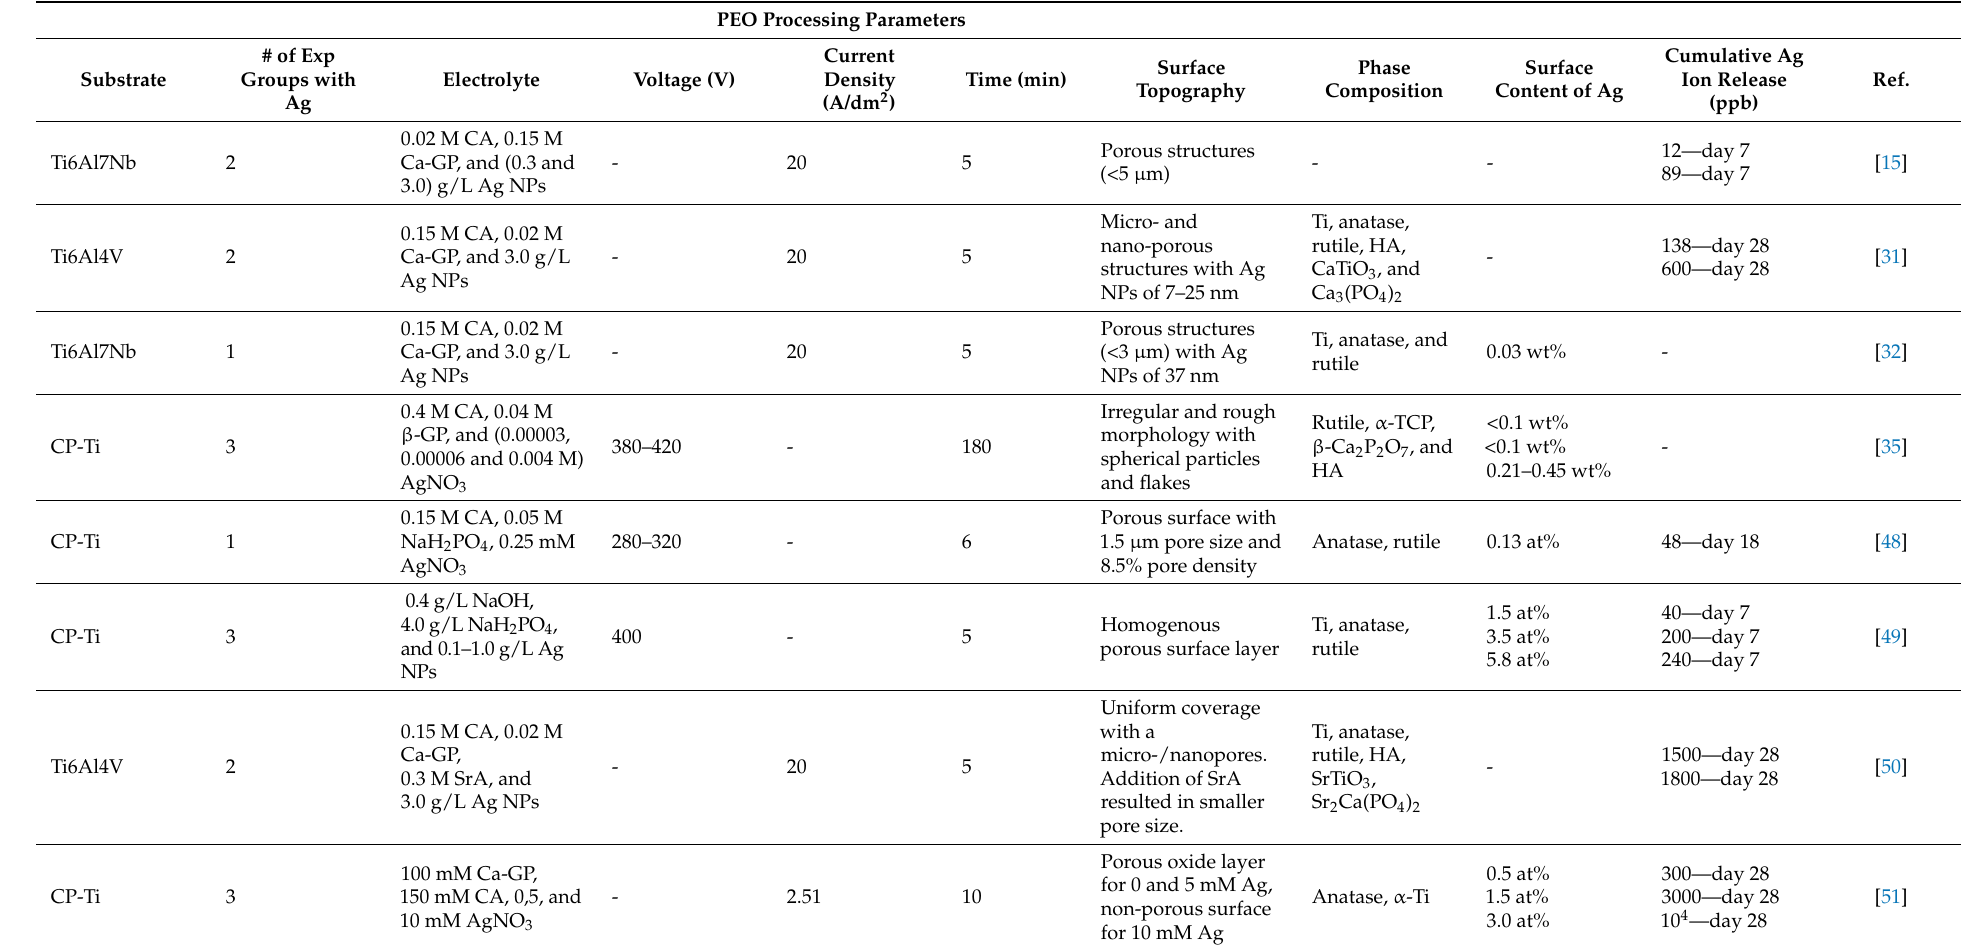
Table 1. The methodological details of the included studies in which Ag was used as the antibacterial agent. PEO Processing